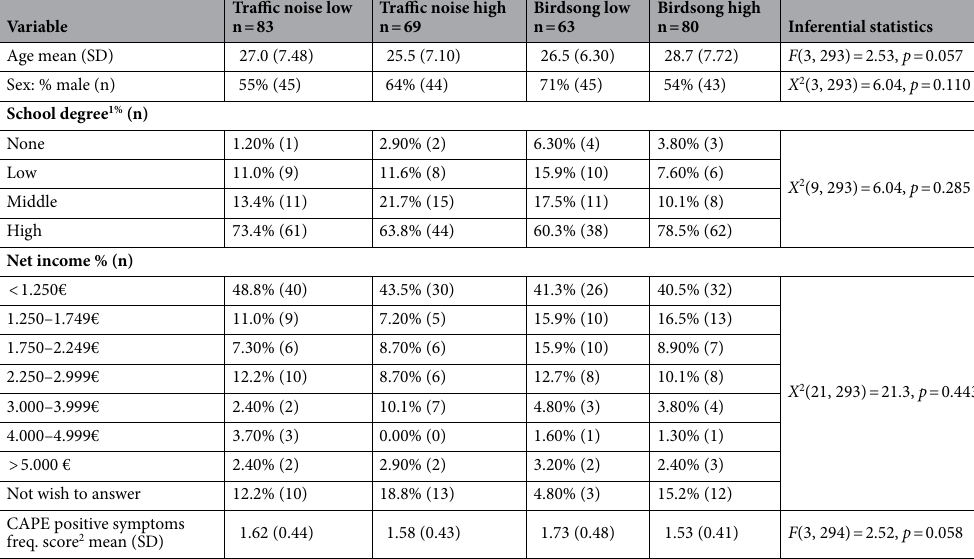
Table 2. Descriptive sample data and between-group differences for socio-demographic variables. 1 The German school system has three type of school degrees; lowest = ‘Hauptschulabschluss’, which can be acquired after the 9th, middle = ‘Realschulabschluss’, which can be acquired after the 10th, and high = ‘Abitur’, which can be acquired after the 12th or 13th school year. 2 Scores can range from 1 to 4, which indicate the average lifetime frequency of psychotic (positive or negative symptoms) symptoms (1 = never, 2 = sometimes, 3 = often, 4 = nearly always). For reference: Mossaheb et al. 19 report means (SD) for frequency on the positive symptom dimension individuals with ultra-high-risk for psychosis (n = 84) vs. without risk (i.e., healthy controls; n = 81): 1.9 (0.5), [CI 1.71–2.02] vs. 1.6 (0.4), [CI